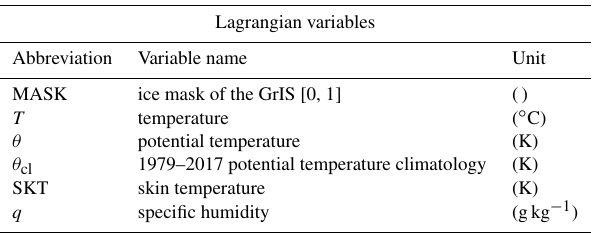
Table 3. The ERA-Interim variables traced along the 8d backward trajectories (Lagrangian